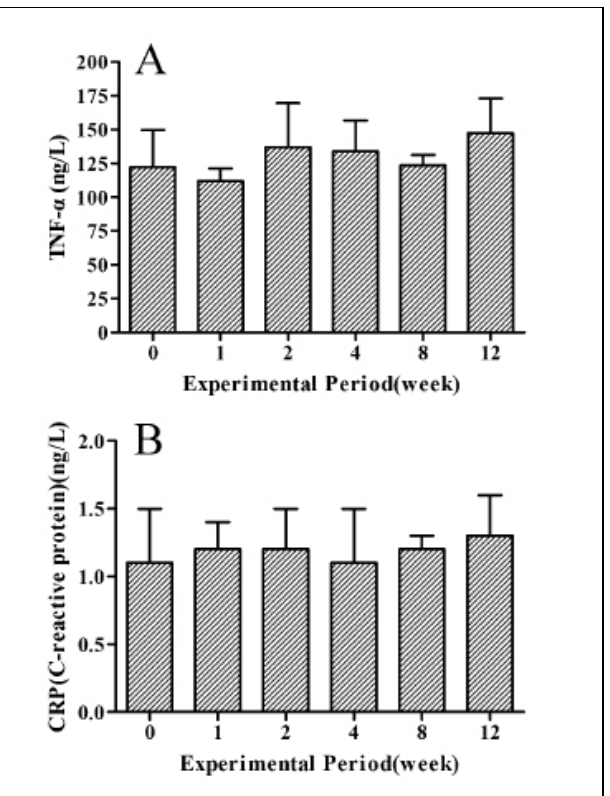
Fig. 4 - Inflammatory factors at pre- and1, 2, 4, 8 and 12 weeks after implantation. Panels A-B show changes of levels of TNF-α and CRP, respectively. Data are the means ± SEM